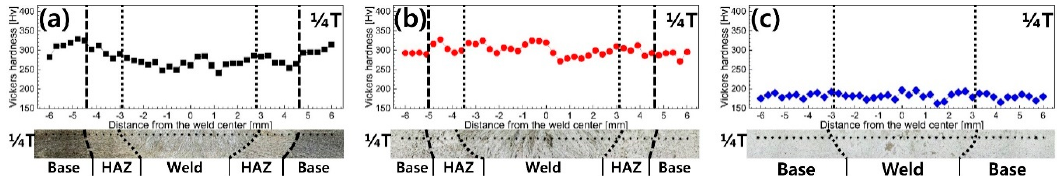
Figure 7. Vickers hardness profiles of high-Mn steel pipes ranging over welded joint regions: ( a ) R, ( b ) 10D, and ( c ) 10DH.